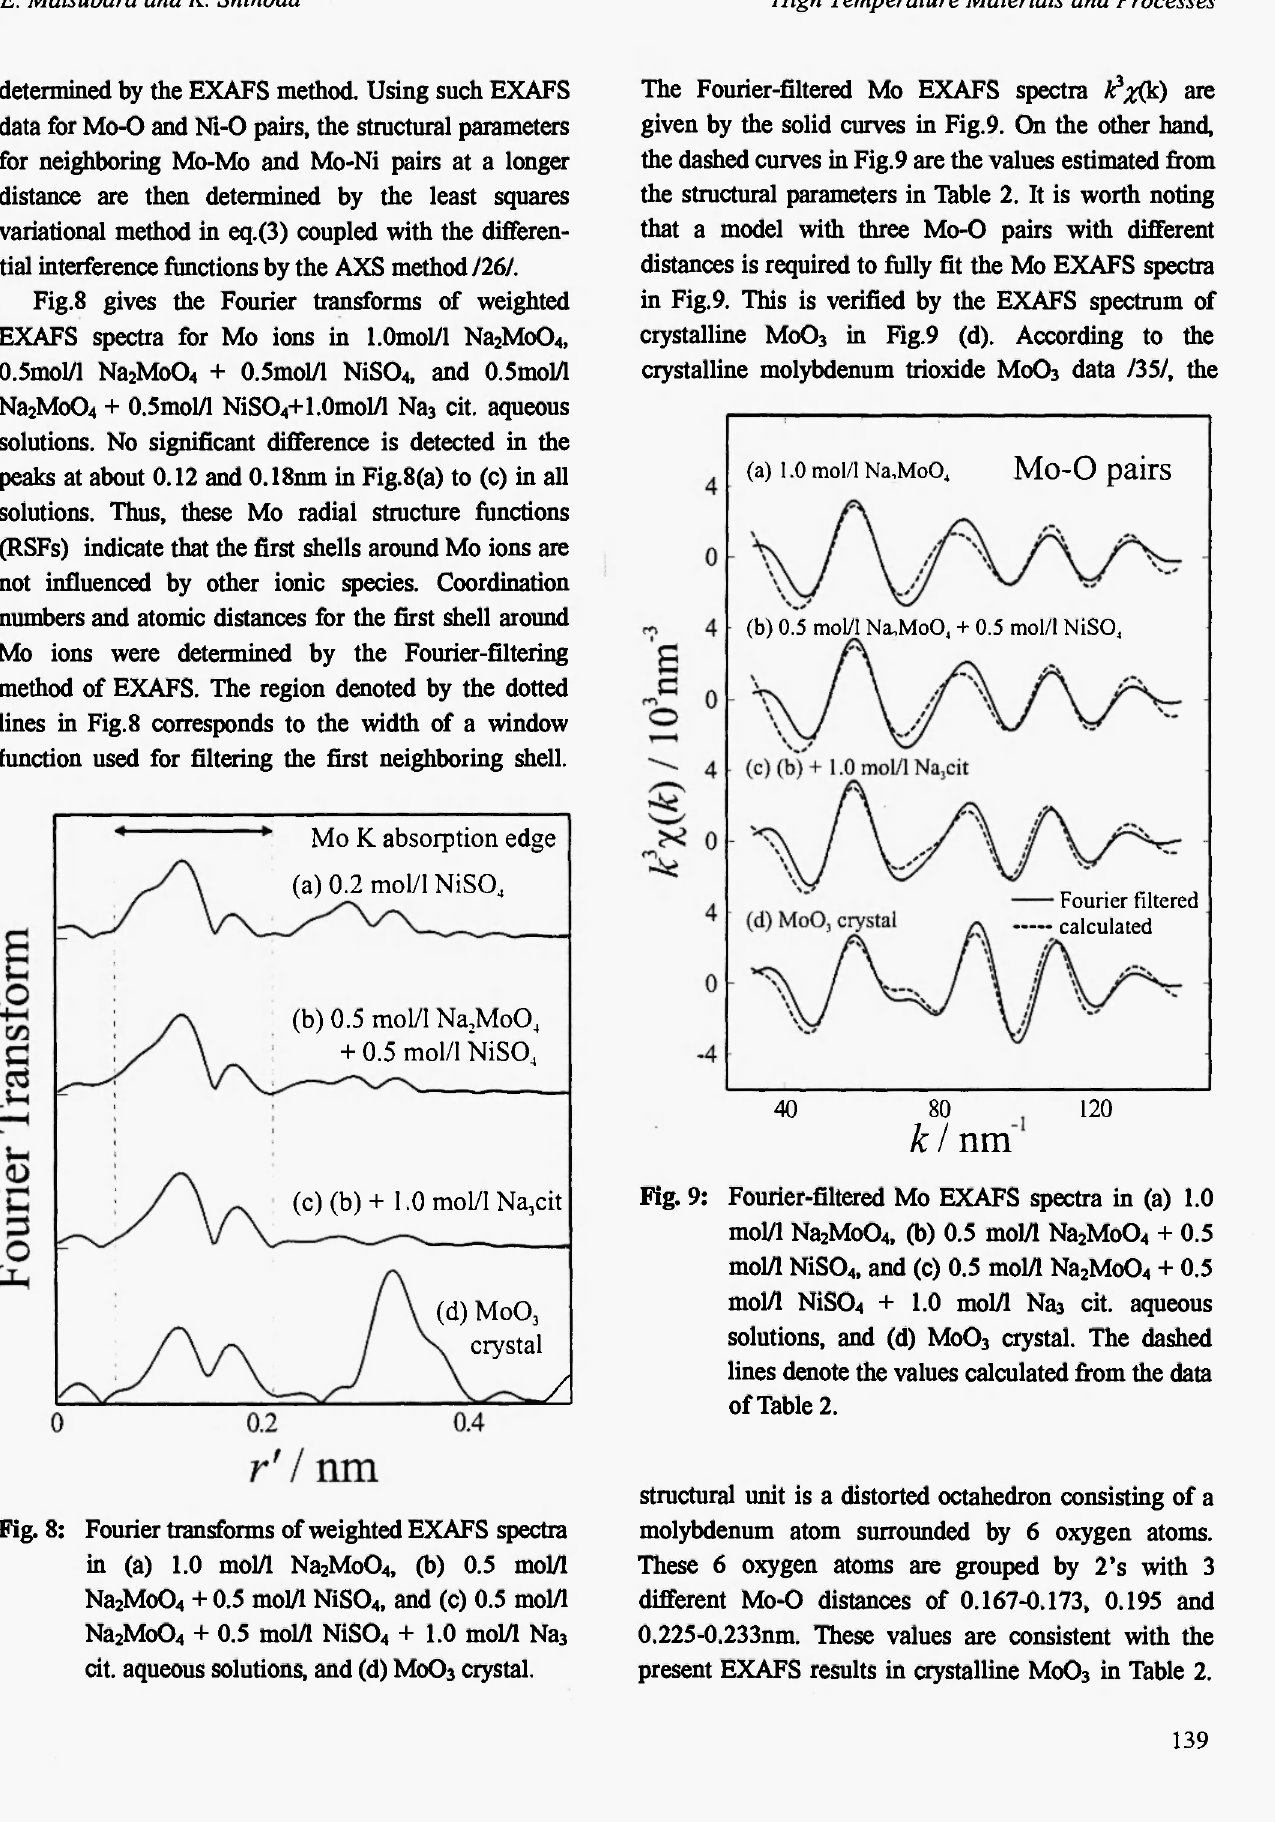
Fig. 8: Fourier transforms of weighted EXAFS spectra in (a) 1.0 mol/1 Na Na Mo0 + 0.5 mol/1 NiS0 2 4 Na Mo0 + 0.5 mol/1 NiS0 2 4 cit. aqueous solutions, and (d) Mo0